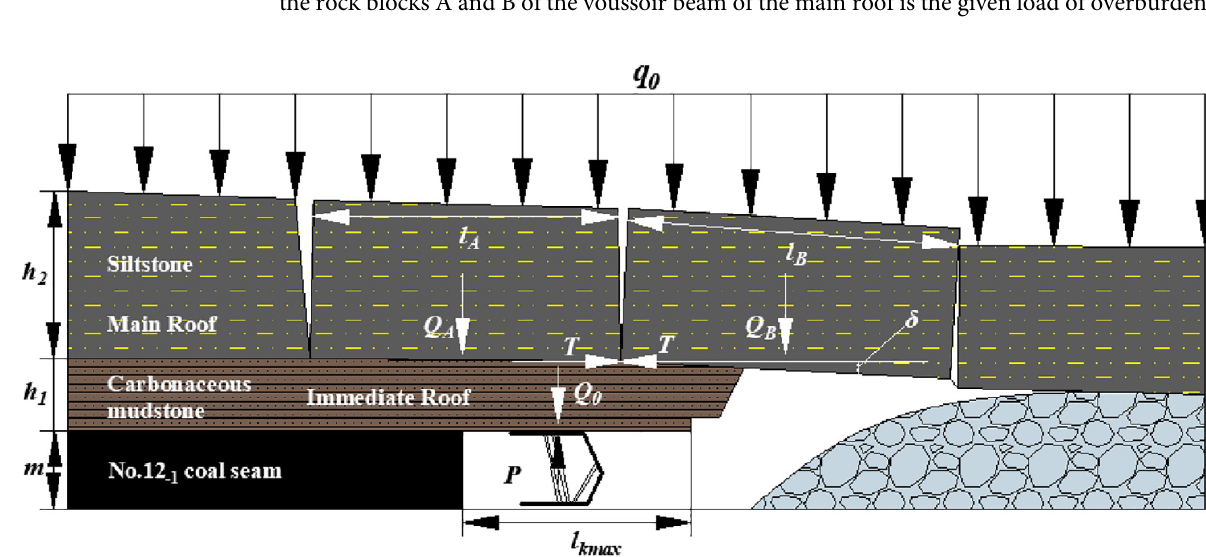
No.12 coal seam. Fig 11 shows the roof structure characteristic after No.12 -1 mining. The interaction system between the shield and roof strata is composed of the shield, cantilever beam of the immediate roof, and voussoir beam of the main roof. And the load on the rock blocks A and B of the voussoir beam of the main roof is the given load of overburden